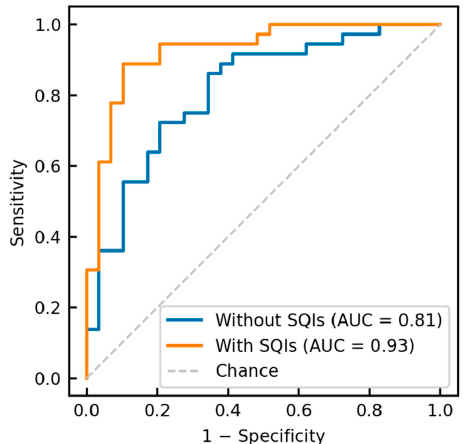
Figure 5. Receiver operating characteristic curves derived from logistic regression with 10-fold cross-validation.